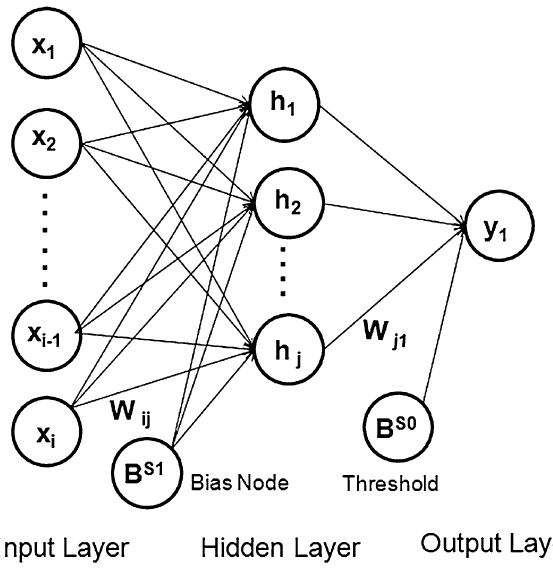
Fig. 6 Schematic of a single hidden layer multiple input–single output (MISO) MLP neural